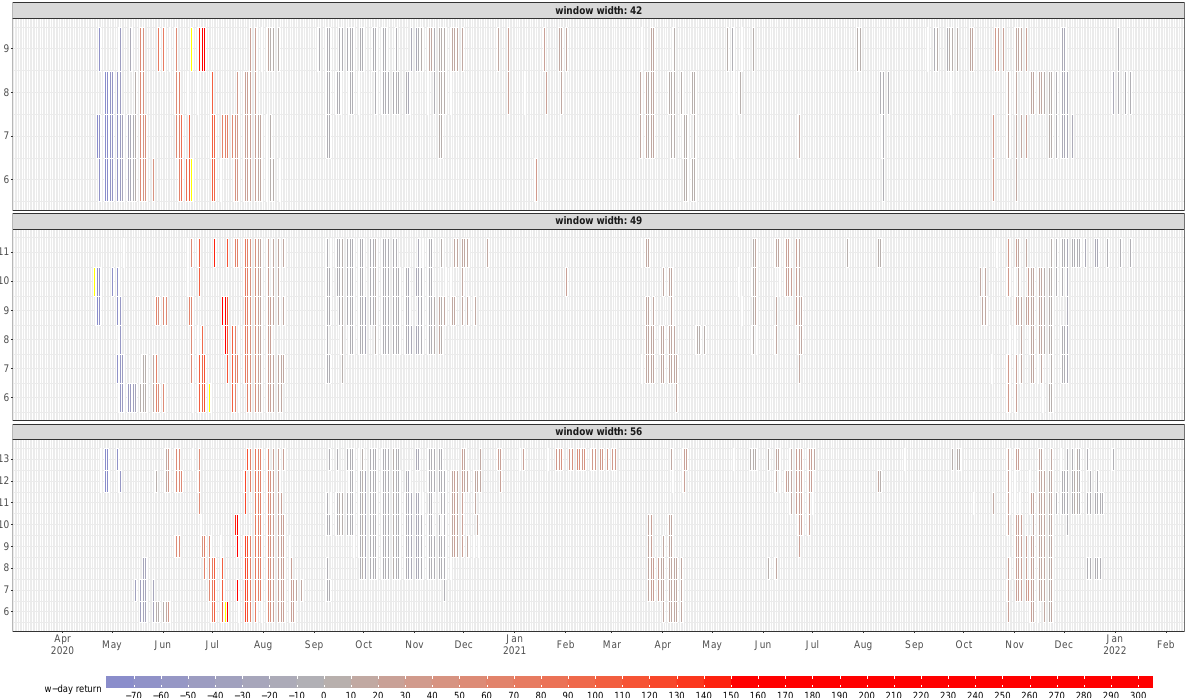
( w ) , of oil futures when w = 42, 49 and 56; with different t